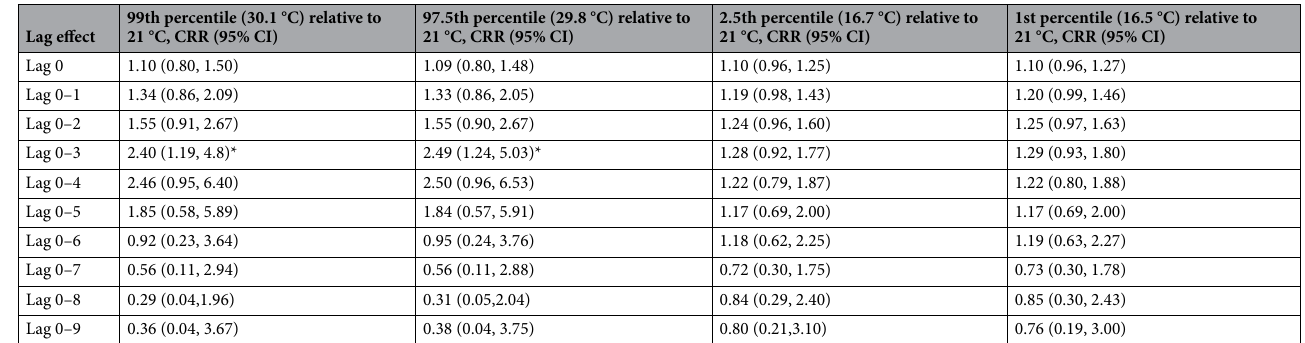
Table 2. The cumulative relative risk (CRR) of stillbirth in extreme heat temperature (99th and 97.5th percentile) and extreme cold temperature (1st and 2.5th percentile) relative to the optimal temperature (21 °C). * p <